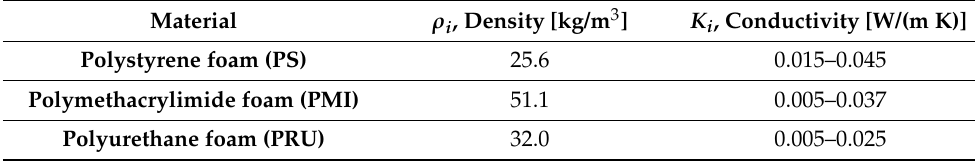
Table 3. Properties of insulant